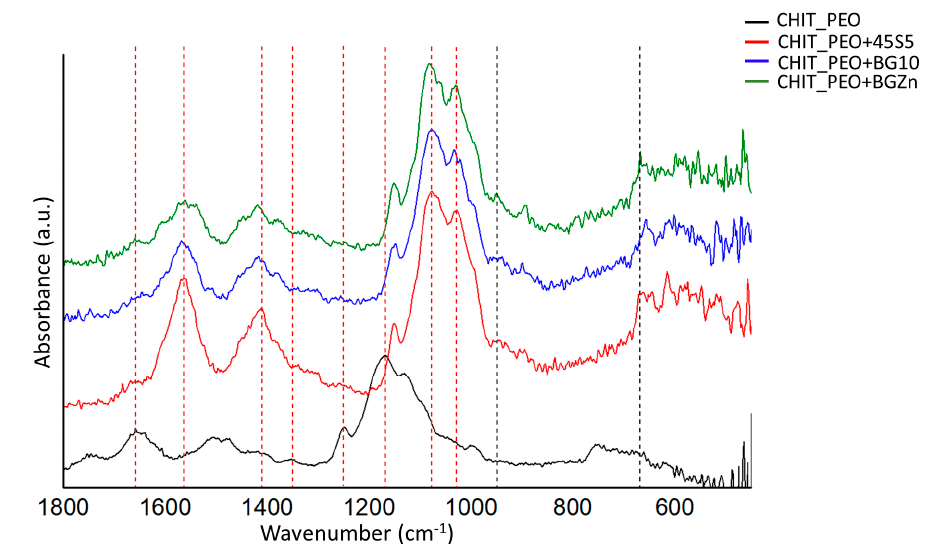
Figure 3. FTIR spectra of CHIT_PEO, CHIT_PEO_45S5, CHIT_PEO_BG10 and CHIT_PEO_BGZn electrospun mats before immersion in SBF solution. The characteristic bands of CH are marked by red dashed line, while bioactive glasses characteristic bands are marked by black dashed line. Table 4. Summary of the average of tensile strain at break and Young’s